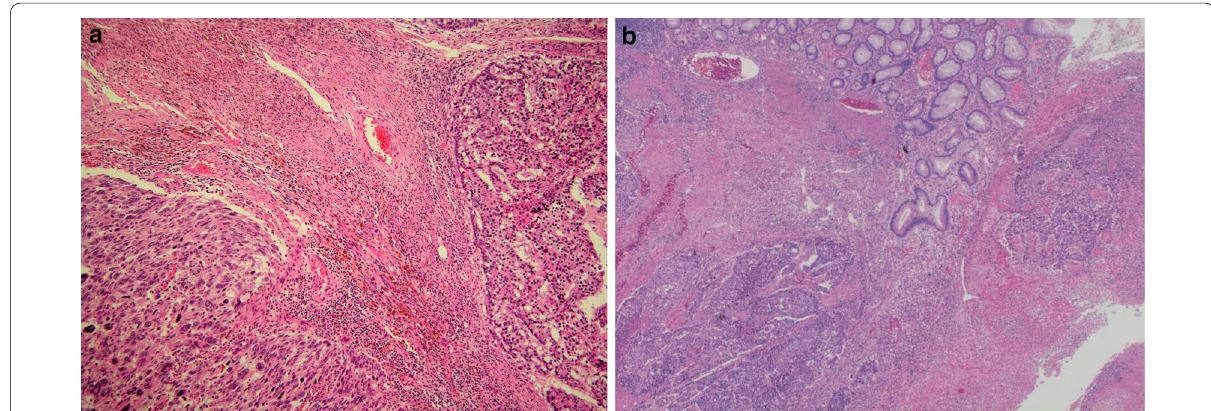
Fig. 5 Histological examination revealing that a large part of the tumor was poorly differentiated adenocarcinoma, and pleomorphic sarcomatous tumor cells were seen in the part of hemorrhagic necrosis, where the transition of carcinomatous to sarcomatous tumor cells was observed ( a ). The carcinoma component was exposed in the ulcer base of the colon ( b )